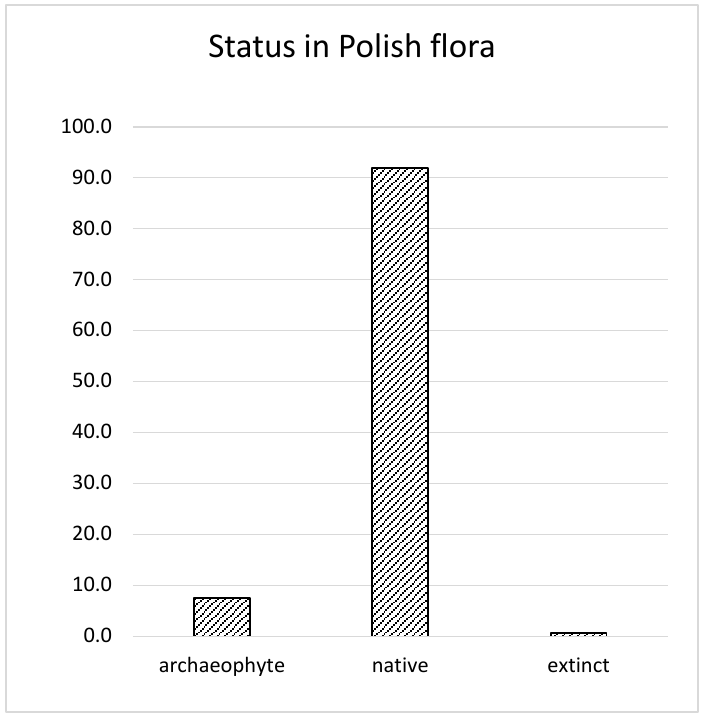
Figure 1. Occurrence status of taxa in Polish flora (%).